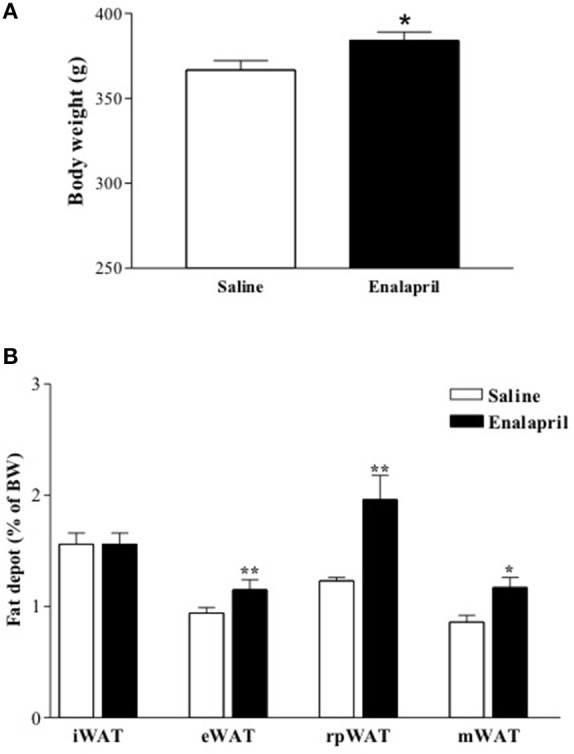
(A) Body and (B) fat depot mass of 90 days old rats treated with saline or enalapril (10 mg/Kg of BW) during the first 16 days after birth.*p < 0.05, **p < 0.01 vs. saline treated animals. Data are shown as mean + SEM, n = 10 rats each group. Inguinal (iWAT), epididymal (eWAT), retroperitoneal (rpWAT) and mesenteric (mWAT) fat depots mass.